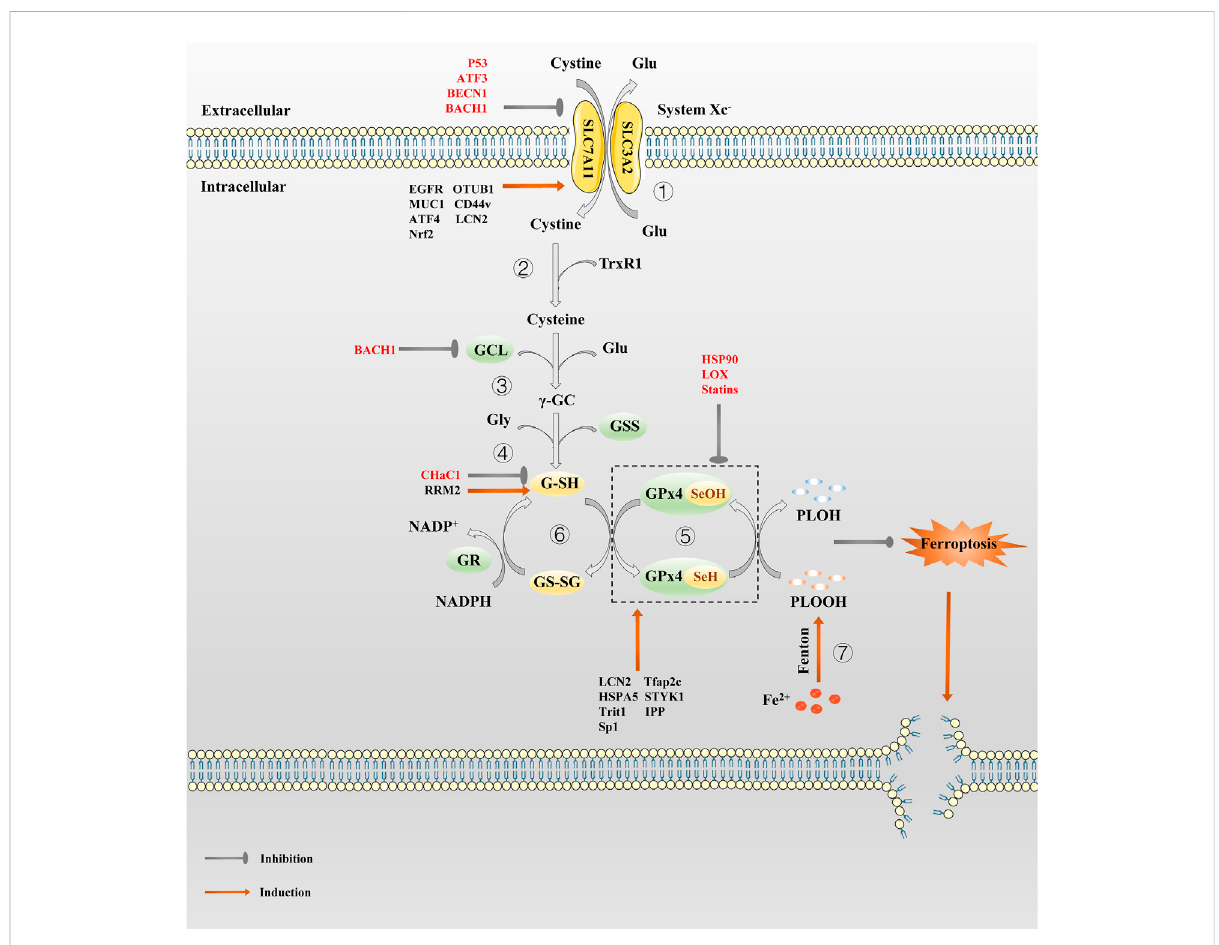
FIGURE 1 The regulation pathwayof System Xc − /GSH/GPx4 inferroptosis. ① System Xc − transportcystine into thecell and reverse Glu out of the cell in a 1:1 ratio. ② Cystine absorbed by System Xc − is reduced to cysteine byG-SH or TrxR1. ③ Then GCL linkscysteineand glutamate to produce γ -GC. ④ γ -GC and Gly are catalyzed by GSS to produce G-SH. ⑤ In the catalytic cycle of GPx4, the GPx4-SeH is oxidized by the P-LOOH to GPx4-SeOH, while G-SH can reduce -SeOH and further activates GPx4, releasing GS-SG to prevent GPx4 from being inactivated. ⑥ GS-SG is reduced to G-SHundertheactionofGRandCoenzymeNADPH.SinceP-LOOHisreducedtoPLOHbyGPx4-SeH,ferroptosisisinhibited. ⑦ Fe 2+ canproducea large number of PLOOH through the Fenton